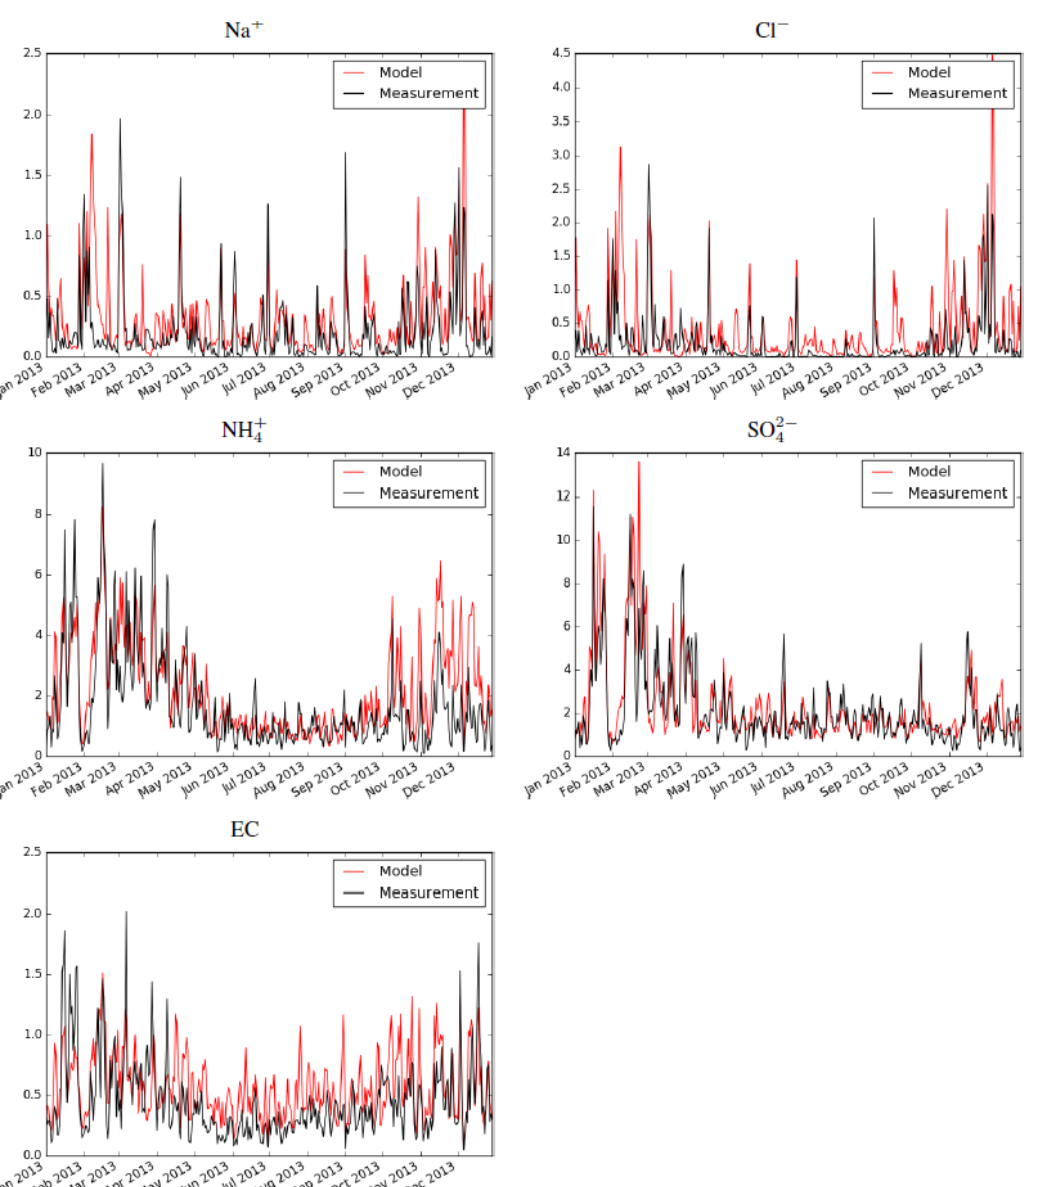
Figure 16. Modeled (red) and measured (black) concentrations of Na + , Cl − , NH +